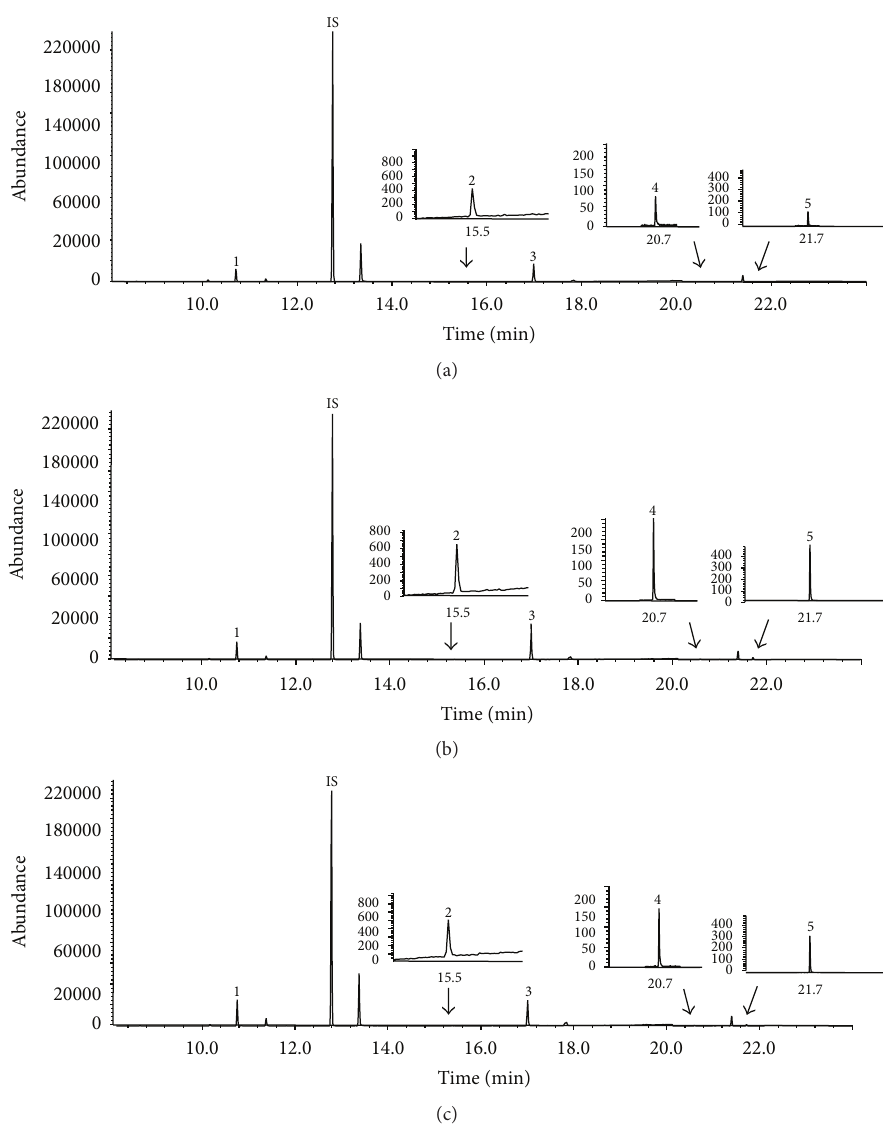
Figure 5: GC-SIM-MS chromatograms of putrescine (1), 𝑁 1 -acetylspermidine (2), spermidine (3), 𝑁 1 -acetylspermine (4), and spermine (5) in cells from control (a), OGD (b), and cocultured OGD cells (c) with hBM-MSCs for 72 h. IS: internal standard (1,6-diaminohexane).